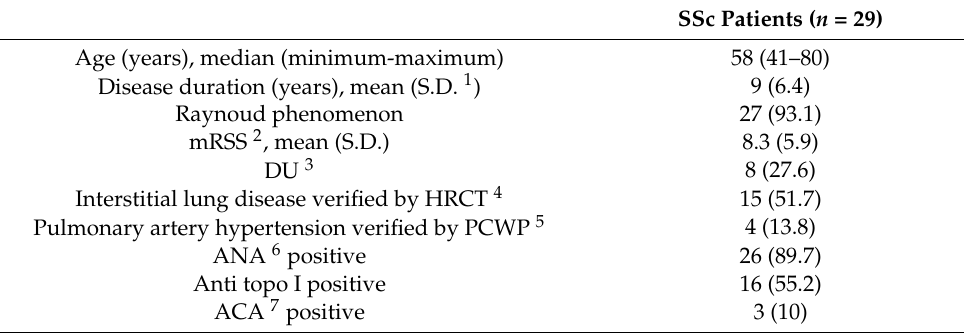
Table 1. Demographic